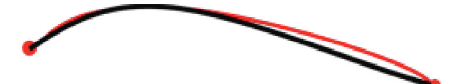
Figure 23: Cubic spline fitted for 1st iteration of